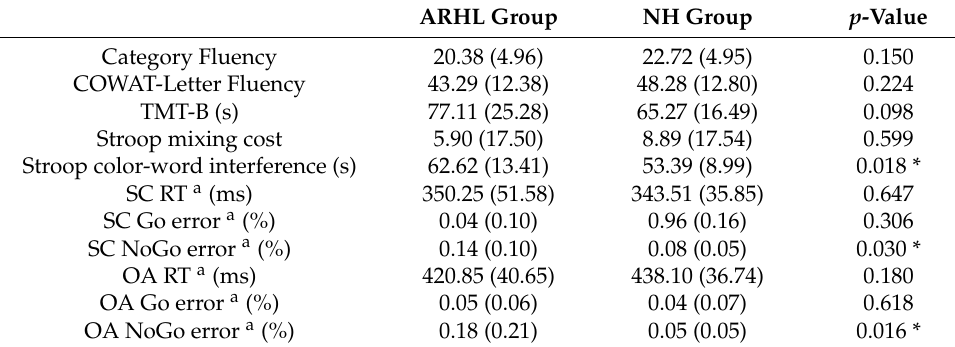
Table 3. Group Means for Cognitive Control Measures.